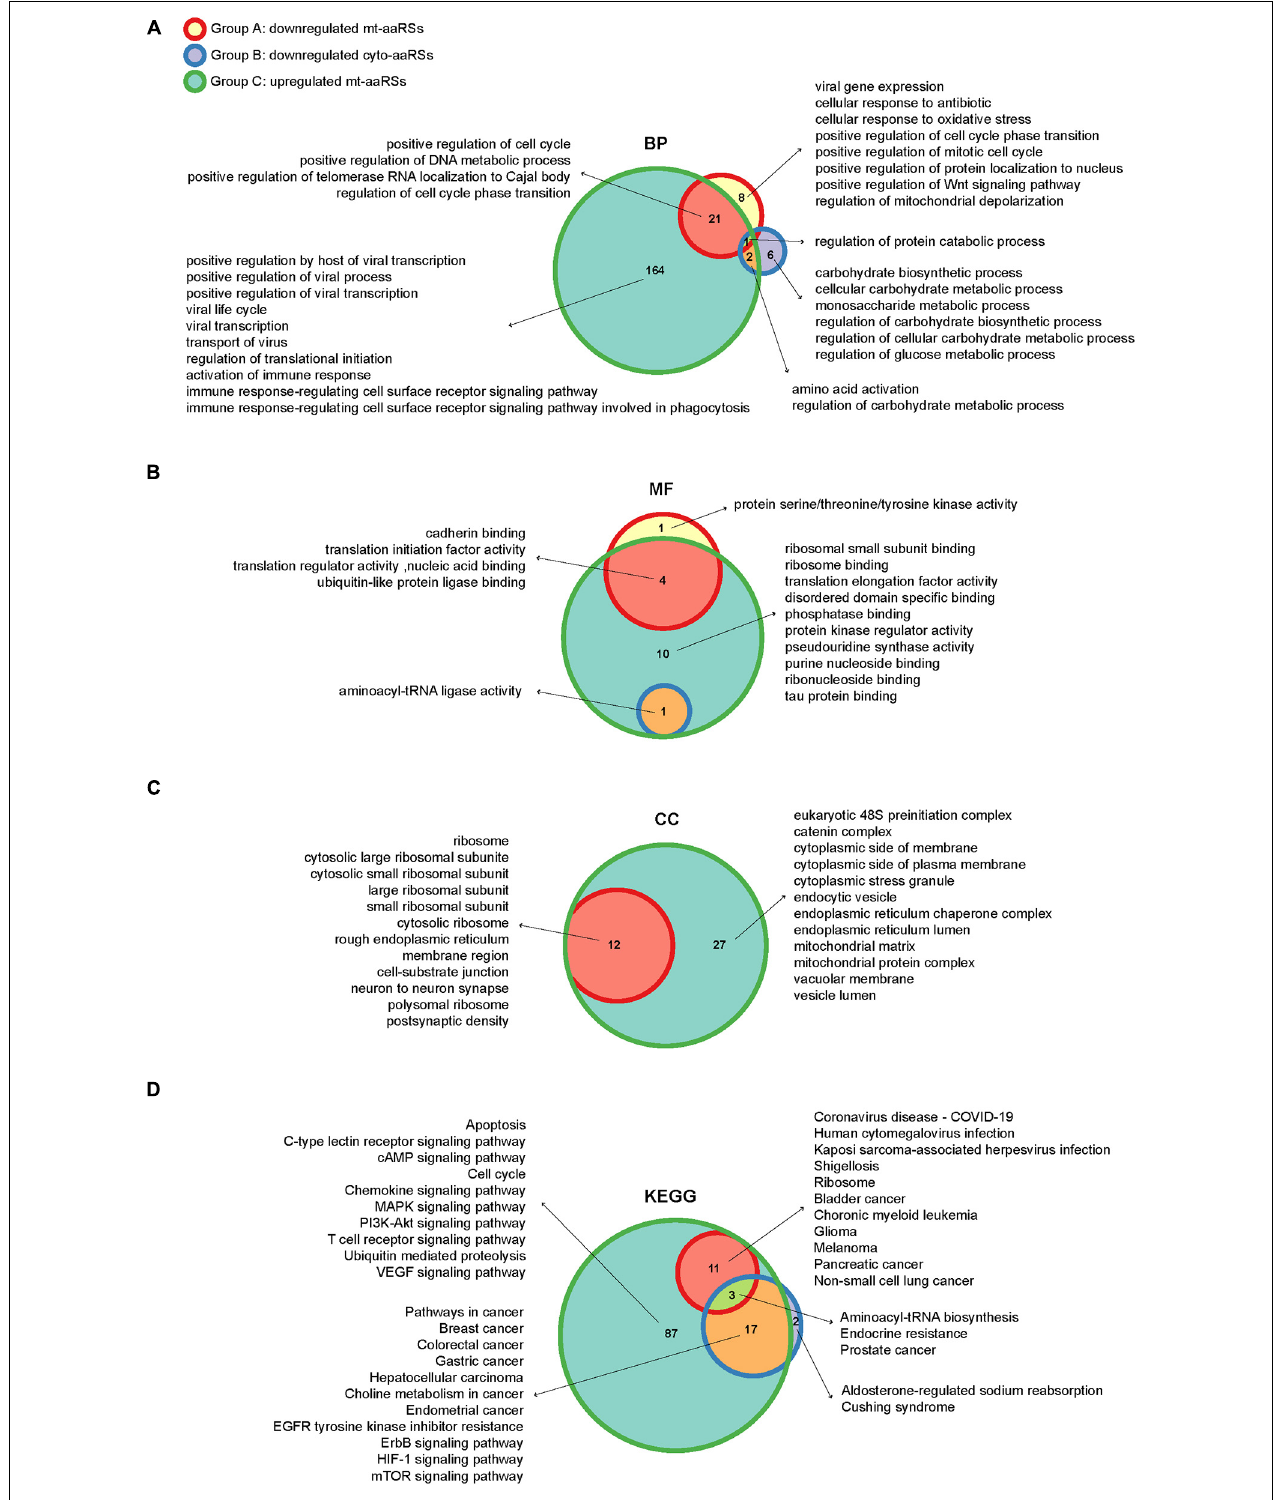
FIGURE 5 | Enriched gene ontology (GO) terms and KEGG pathways of the intermediate (IN) nodes. Wayne diagrams of enriched GO terms in biological process (A) , molecular function (B) and cellular component (C) categories, as well as enriched KEGG pathways (D) for IN nodes in different groups. BP, biological process; MF, molecular function; CC, cellular